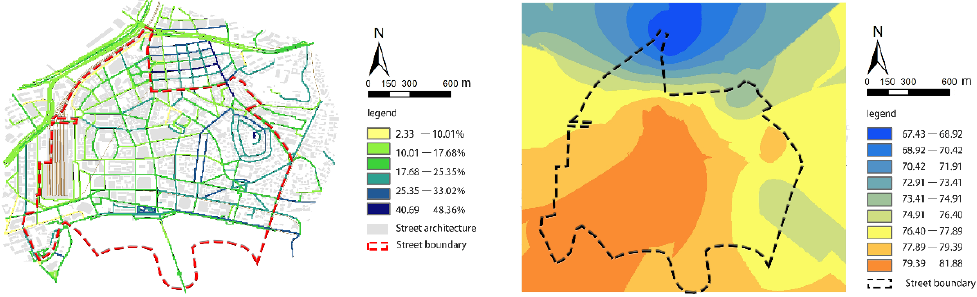
Figure 6. The pedestrian index of Zhongshan Road after superimposing the green viewing rate.